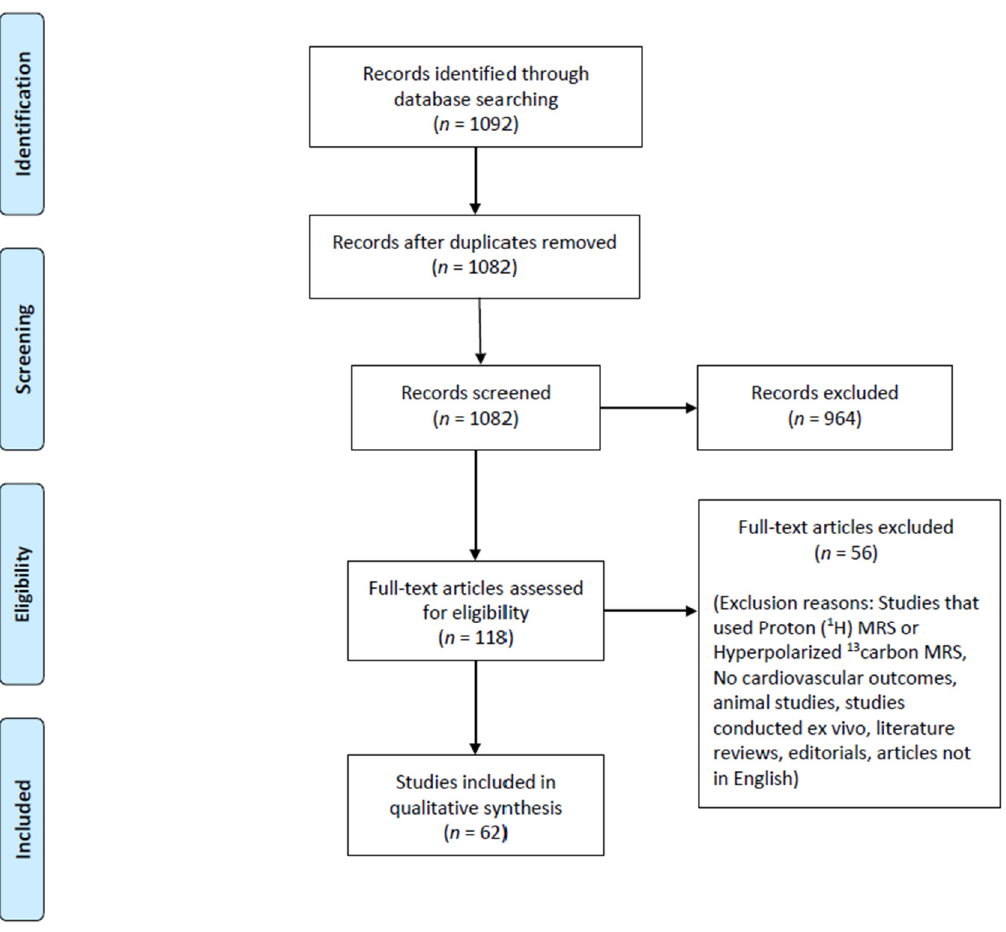
Figure 1. PRISMA flow diagram of the study selection process. Table 1. Table of studies included in the systematic review and their characteristics